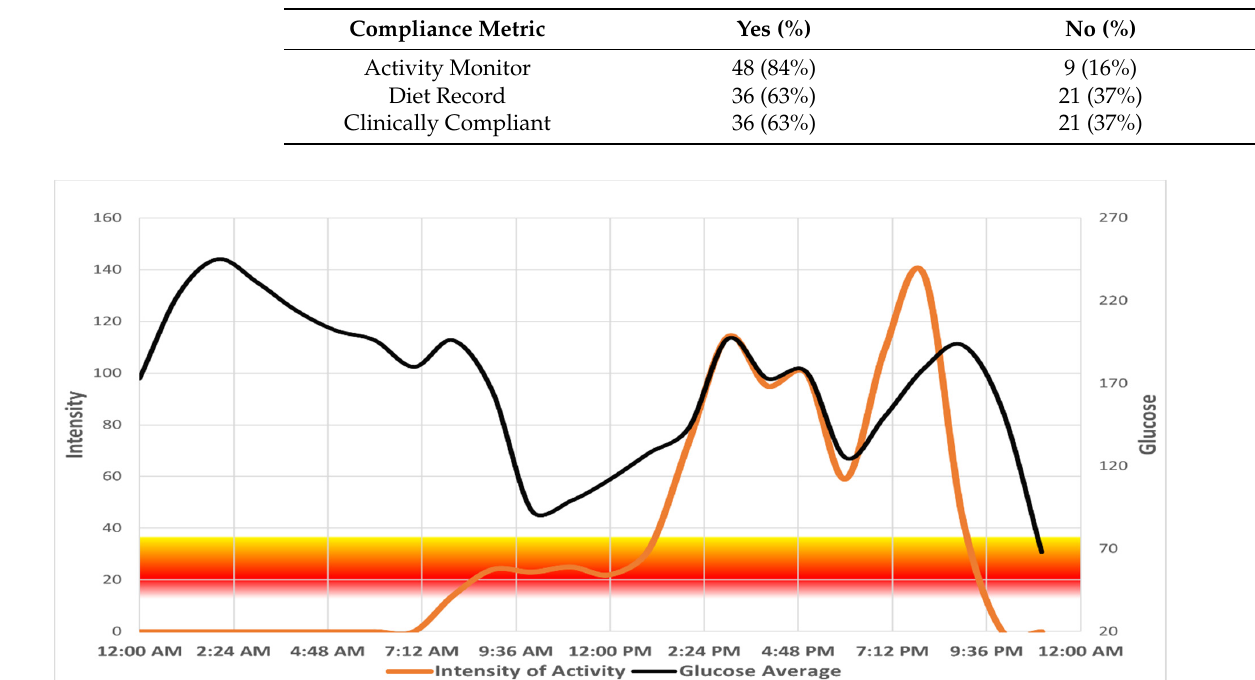
Table 2. Results of compliance.